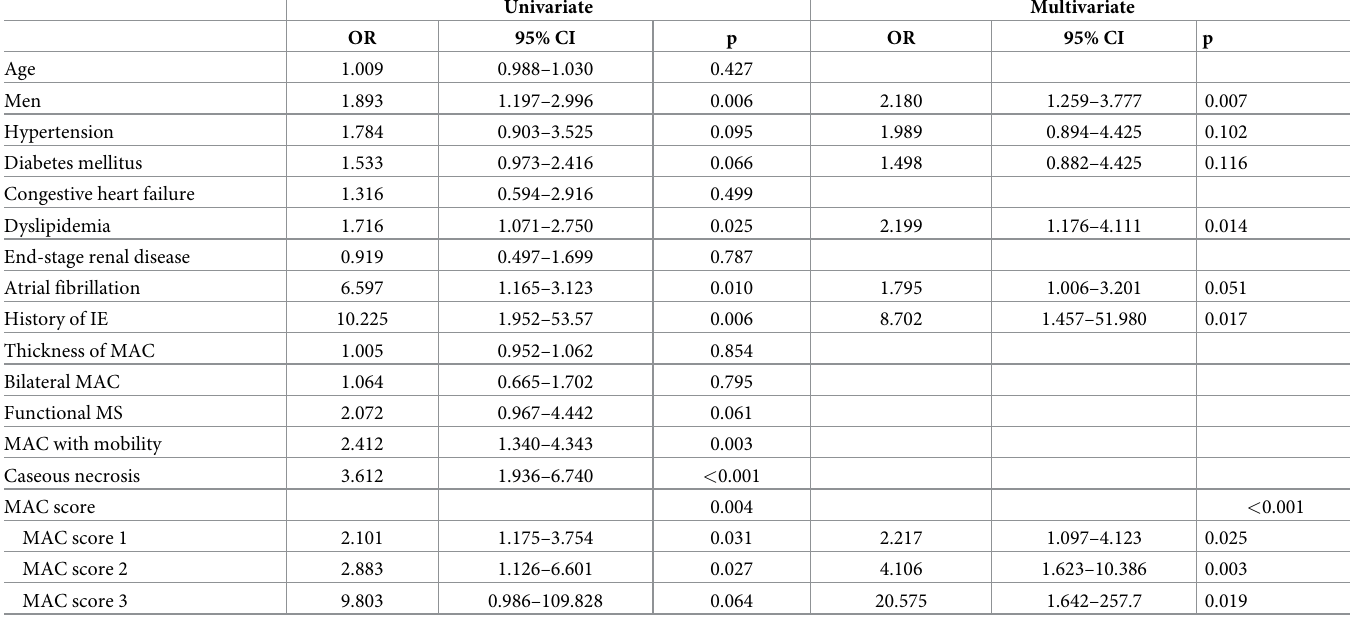
Table 3. Logistic regression for independent factors in association with